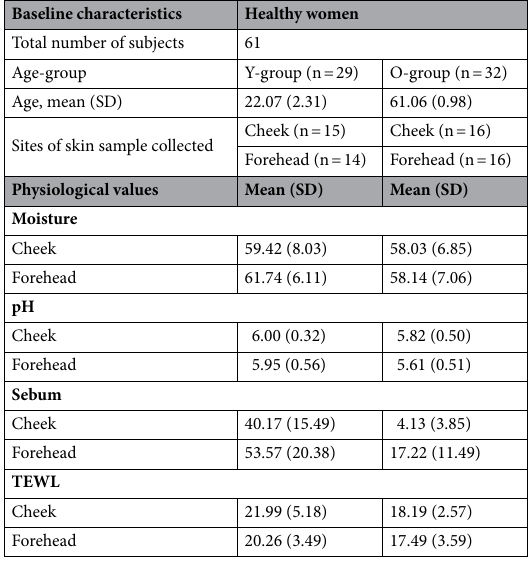
Table 1. Characteristics of subjects for aged related skin microbiome and mycobiome